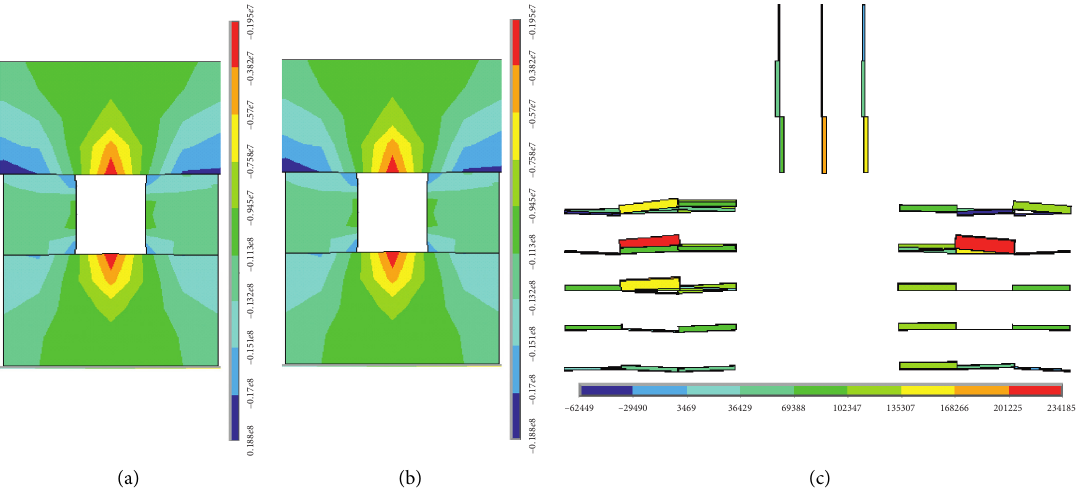
Figure 6: Cloud diagram of stress distribution and bolt force in surrounding rock before and after support: (a) vertical stress diagram without support; (b) vertical stress diagram under supporting condition; (c) axial stress diagram in static state.